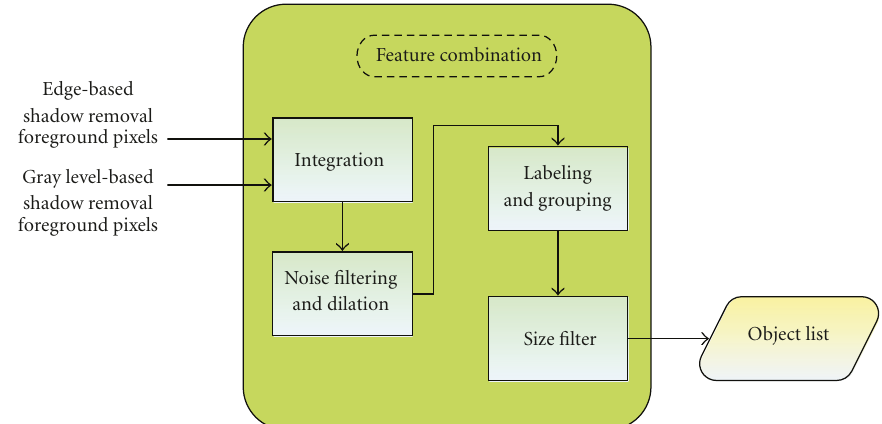
Figure 21: Flowchart of feature combination.